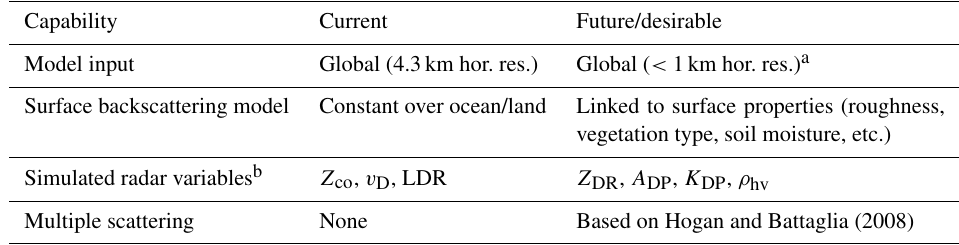
Figure 2. Flow chart illustrating the overall structure of the Wivern E2E simulator. The integrated hydrometeor content and the 4.0km height winds are shown at the top as examples of input fields from the reference global model whereas outputs of the simulator (reflectivities and line-of-sight (LOS) winds) for a WIVERN cross section that will be examined later (Figs. 12–15) are presented in the bottom colored panels. Table 2. Current and future capabilities of the WIVERN E2E